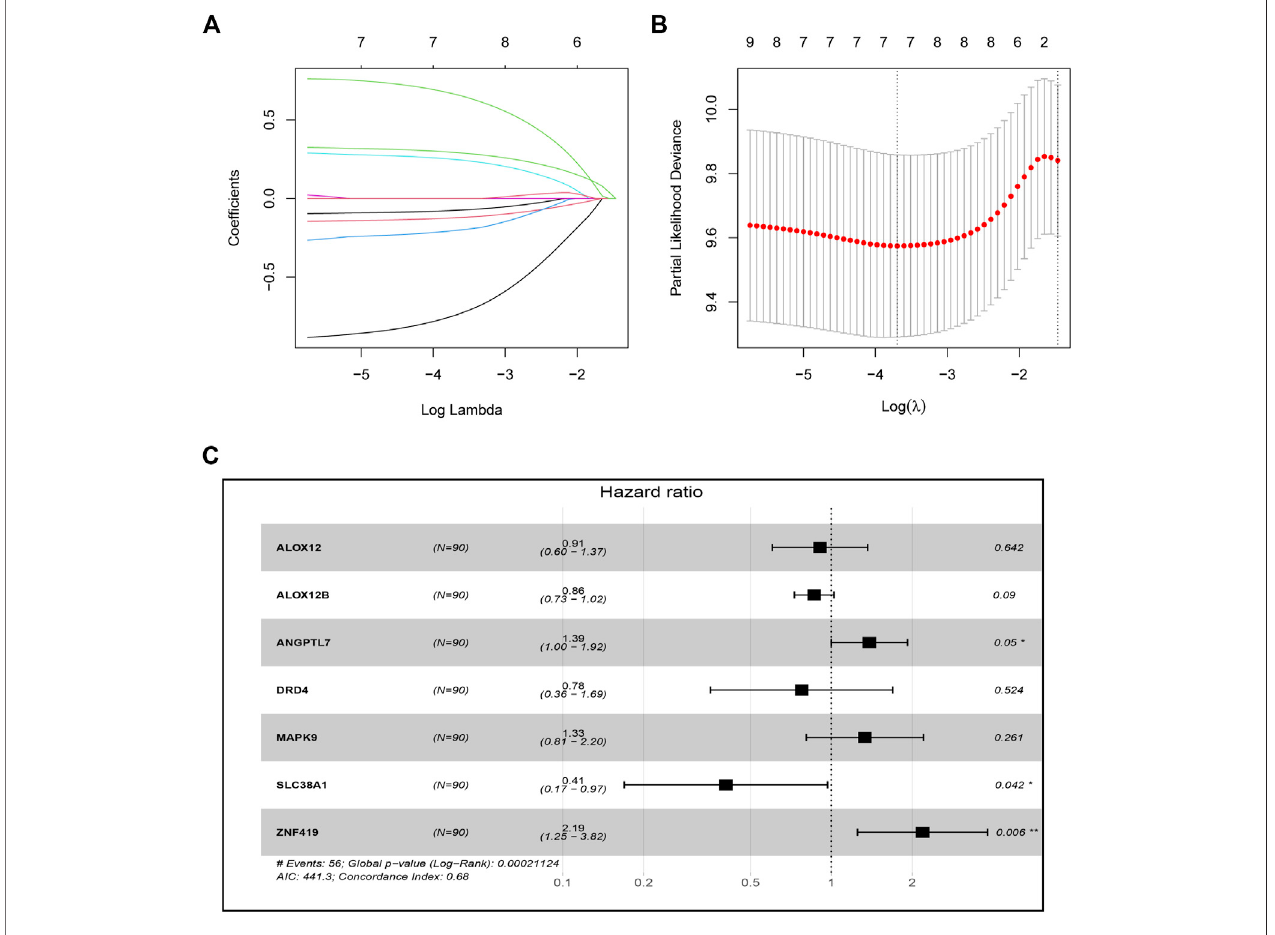
FIGURE 1 | Construction of the seven-ferroptosis-gene signature. (A) Cross-validation for tuning parameter screening upon LASSO regression analysis. (B) LASSO coef fi cient pro fi les for those intersected genes. (C) Forest plot of hazard ratios exhibiting the prognostic worth of seven FRGs.